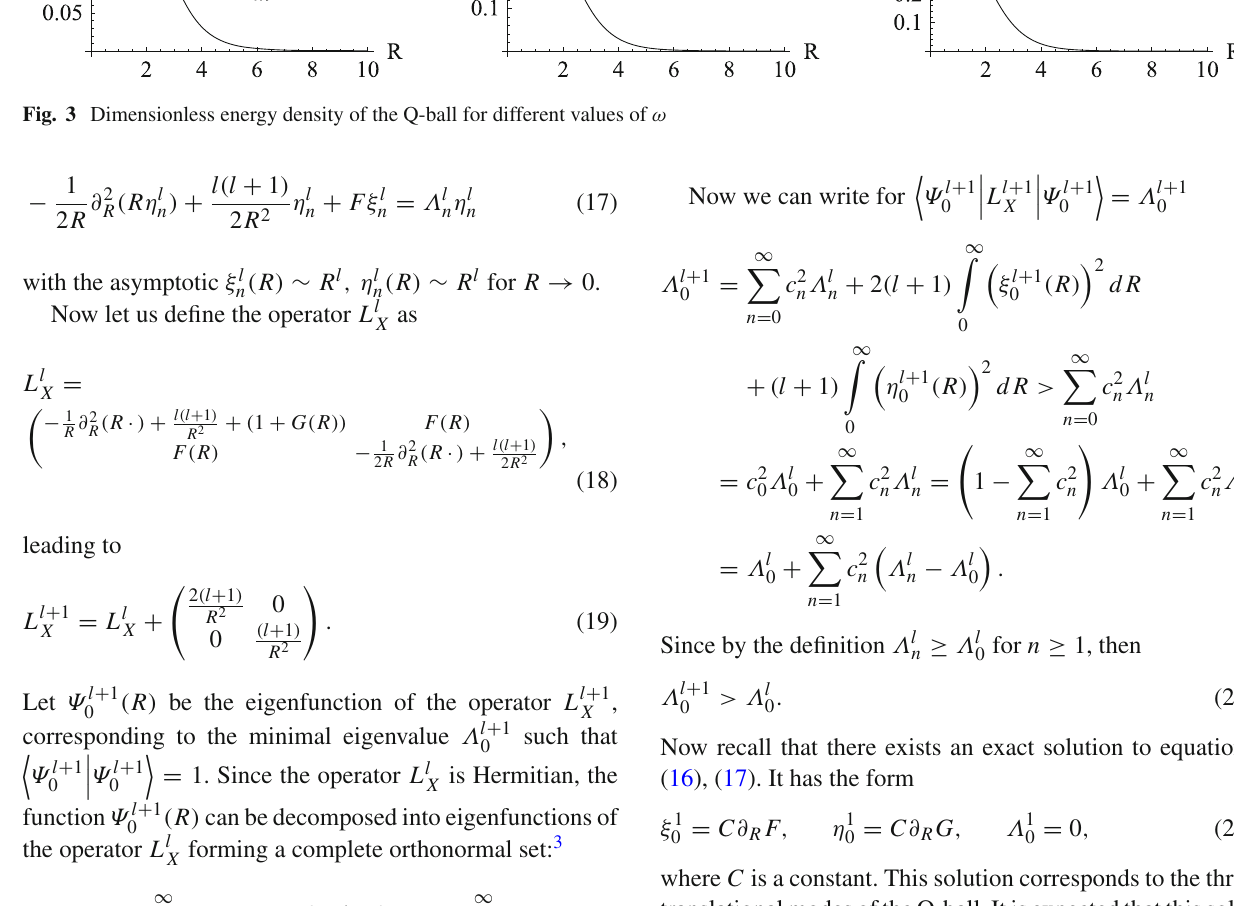
Fig. 3 Dimensionless energy density of the Q-ball for different values of ω